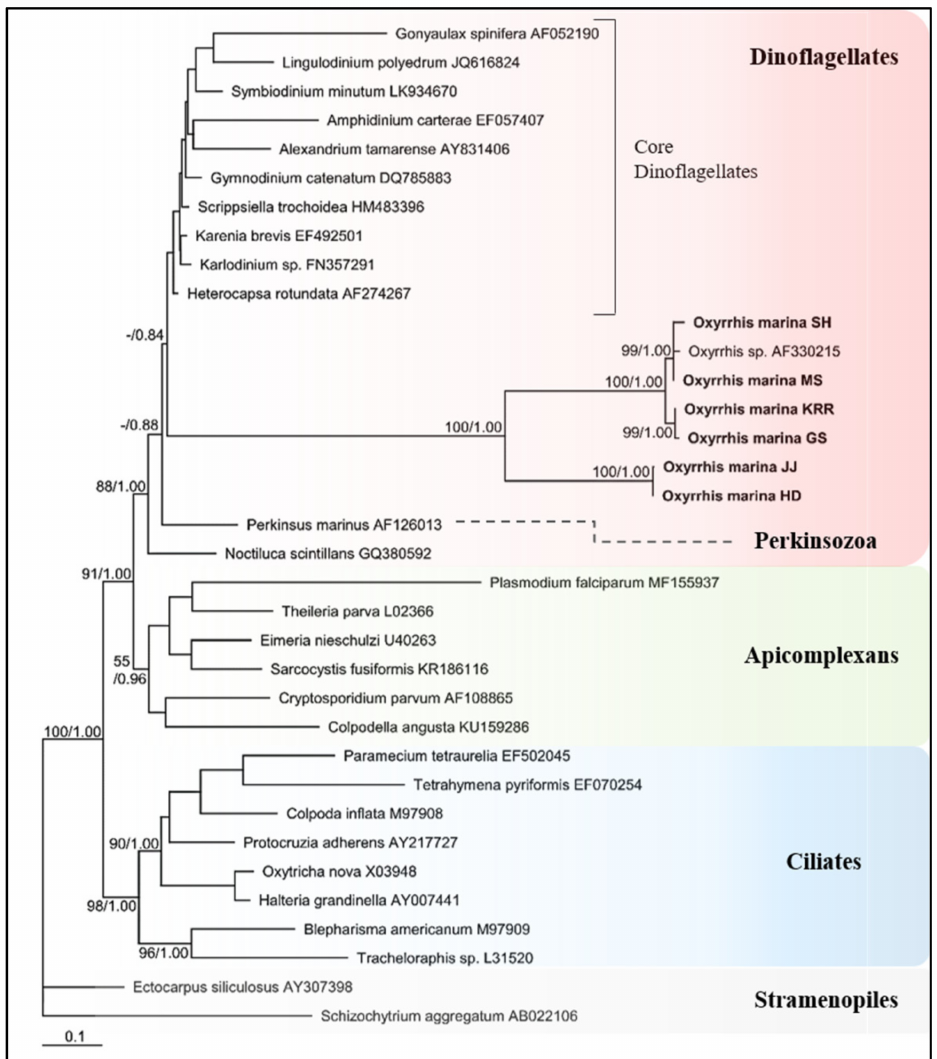
Figure 4. Consensus Maximum likelihood tree of nuclear small subunit (SSU) sequences for 6 strains of Oxyrrhis spp. with other Dinoflagellates, Perkinsozoa and Apicomplexans, Ciliates and outgroup Stramenopiles. The branch lengths are proportional to the number of base changes. The numbers near the branches indicate the Bayesian posterior probability ( left ) and Maximum likelihood bootstrap values ( right ). Posterior probabilities ≥ 0.5 are